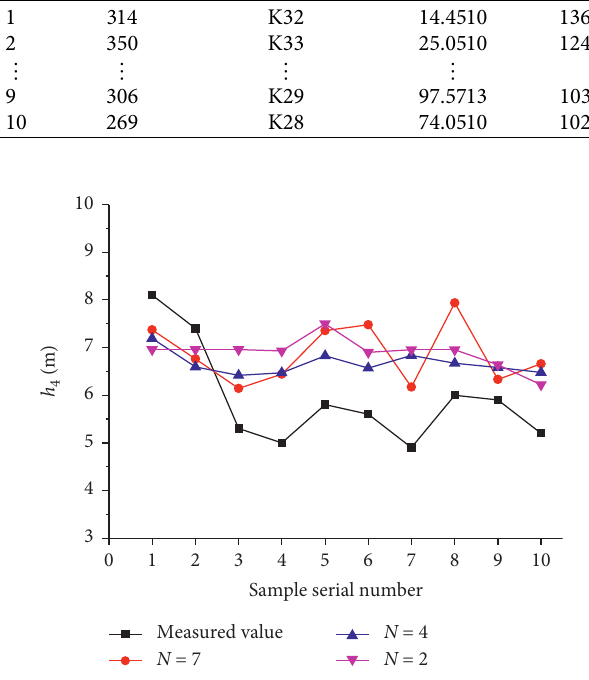
Figure 9: The prediction curve of h 4 when the number of BP neural network neurons was 2, 4, and 7,